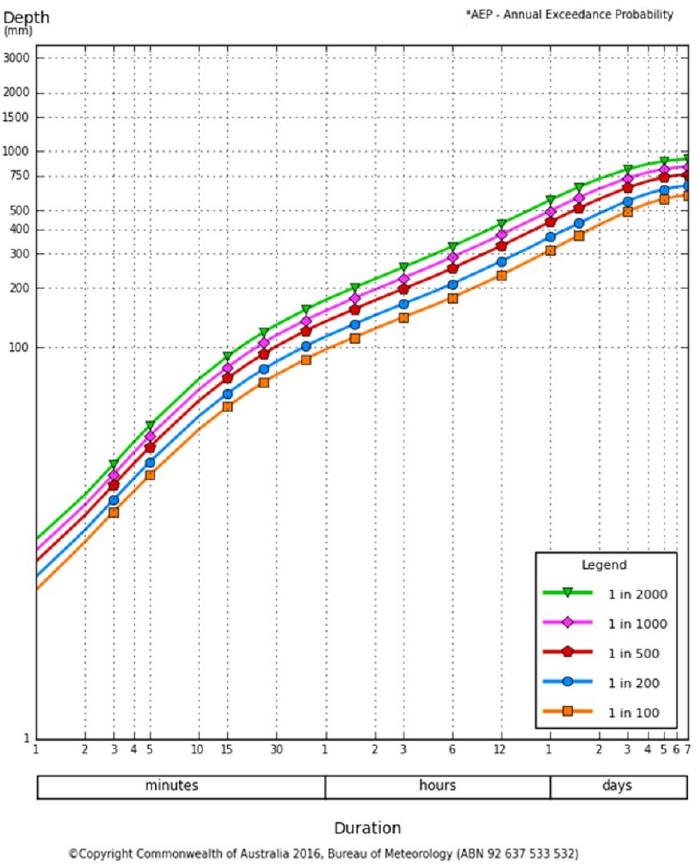
Figure 11. Bureau of Meteorology intensity, frequency, duration curves for the study site location [45]. *AEP (1 in 100 is 1% AEP, 1 in 200 is 0.5% AEP, 1 in 500 is 0.2% AEP, 1 in 1000 is 0.1% AEP and 1 in 2000 is 0.05% AEP)